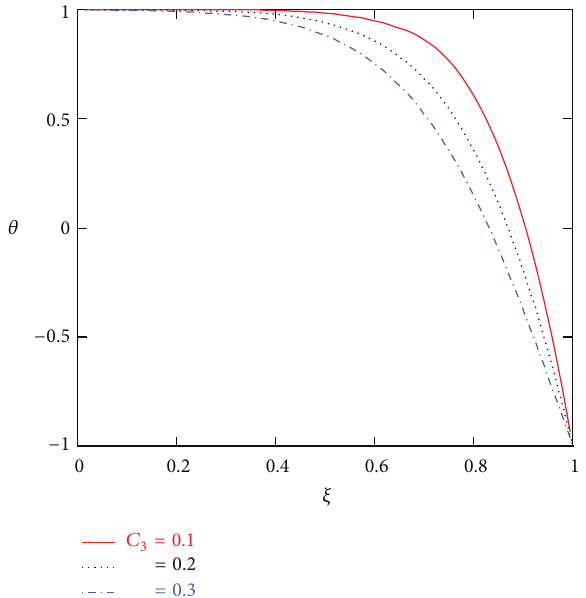
Figure 5: Temperature profiles at 𝜏 = 0.05 in slab with temperature- dependent thermal conductivity for 𝐶 1 = 0 , 𝐶 2 = −1 , 𝛽 1 = 0 , 𝛽 2 = = 1 , and (𝑀, 𝑁) = (40, 4) with 𝜉 -domain division into three 10 , 𝜃 0 subdomains (i.e., 𝐺 = 1/3 ).